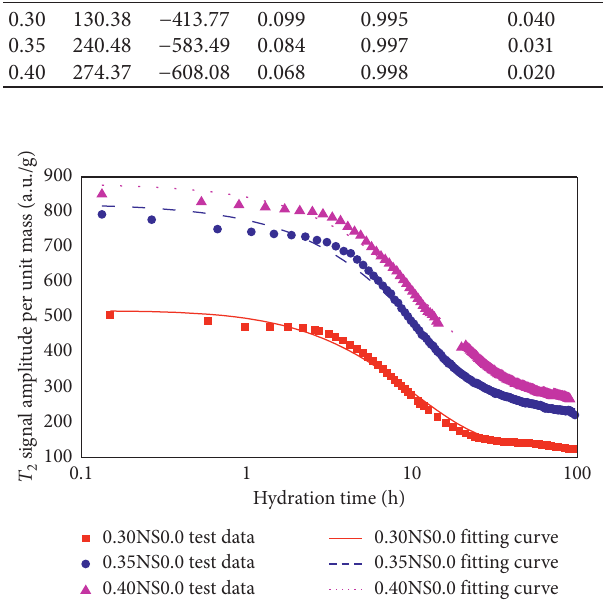
Figure 7: Experiment data and fitting results of pure cement pastes with different w/c.